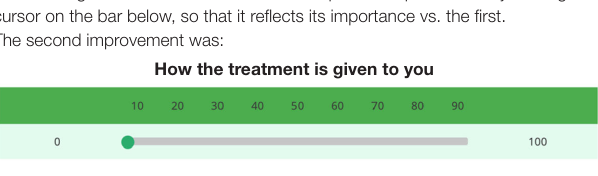
TABLE 5 | Example of the SW choice task—point allocation. The improvement of the following characteristic was found to be the most important for you: Chance of survival 5 years after starting this cancer treatment For this reason, we assign it a score of 100